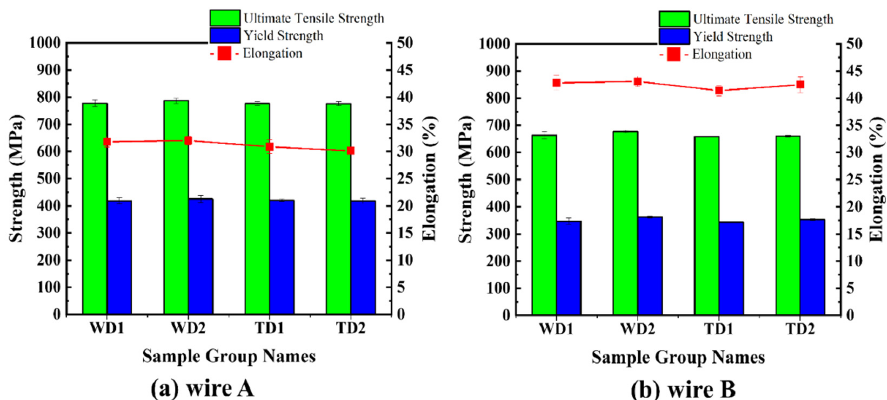
Figure 6. Comparison of tensile properties in the WAAM-fabricated NAB ( a ) wire A; ( b ) wire B. The deposited NAB components using wire B showed an average tensile strength of 663.9 MPa ± 12.9 MPa, an average yield strength of 347.06 MPa ± 11.7 MPa, and an aver-